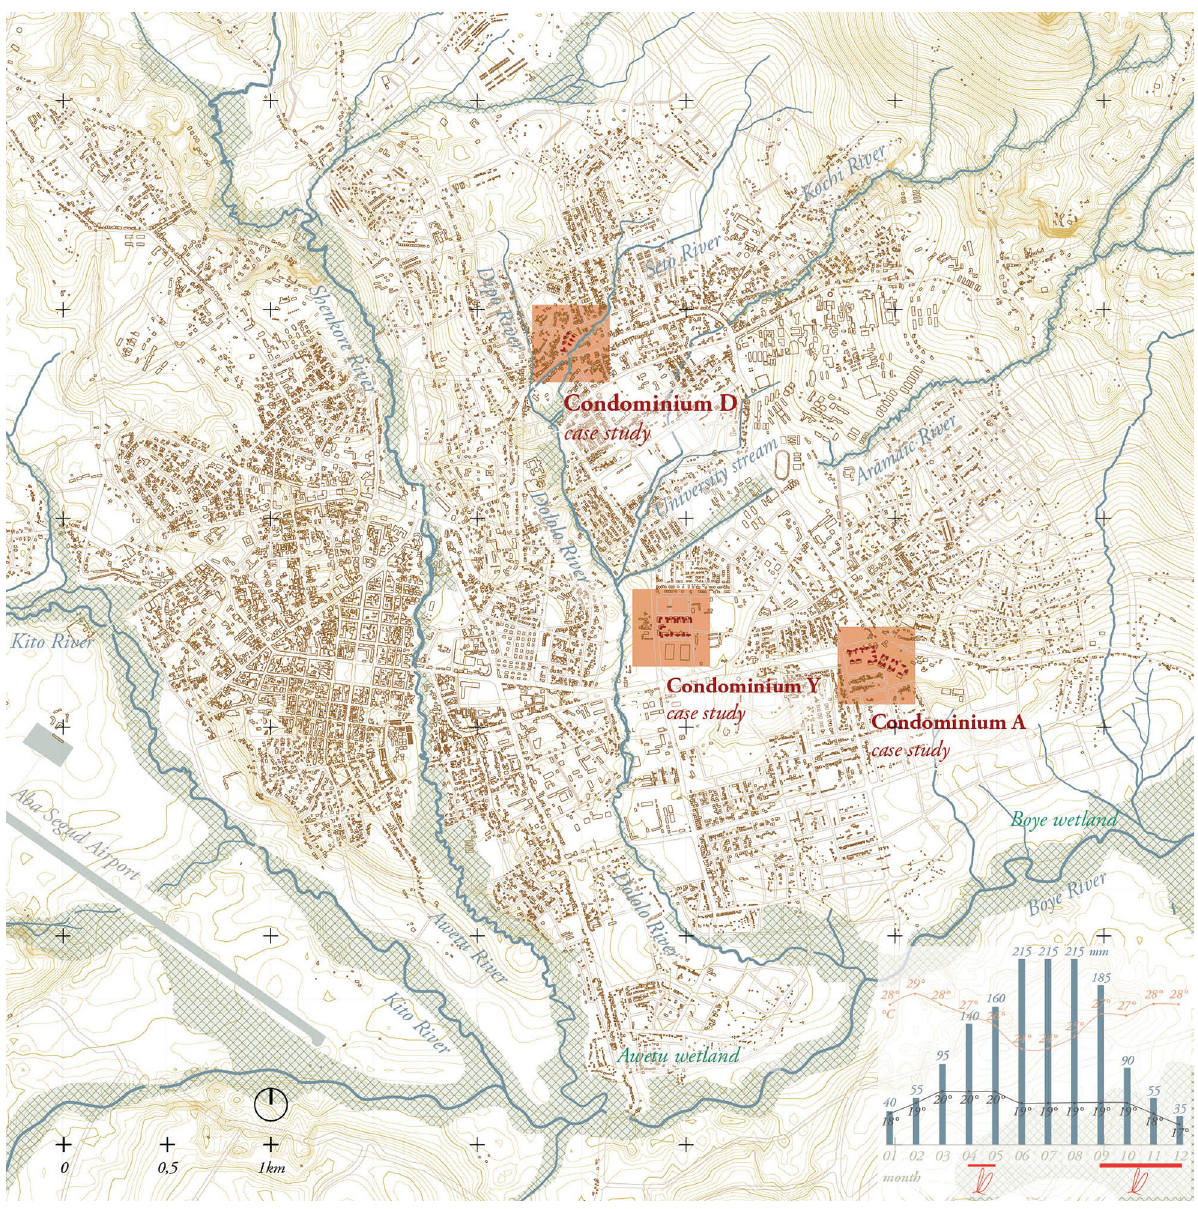
Fig 1. Location of the researched condominiums along Jimma’s floodplains. Jimma is located in forested foothills and has an extended water network with wetlands in the south. Rivers are mapped in dry season situation. Bottom graphic shows monthly average rainfall (mm) and temperature (˚C) with indicated malaria transmission season. Map drawn by the authors, based on https://www.usgs.gov/ and